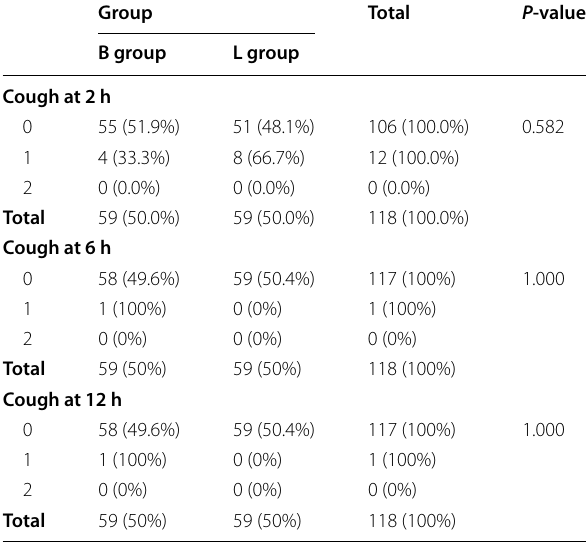
Table 4 Significance of postoperative cough at the end of 2, 6, and 12 h